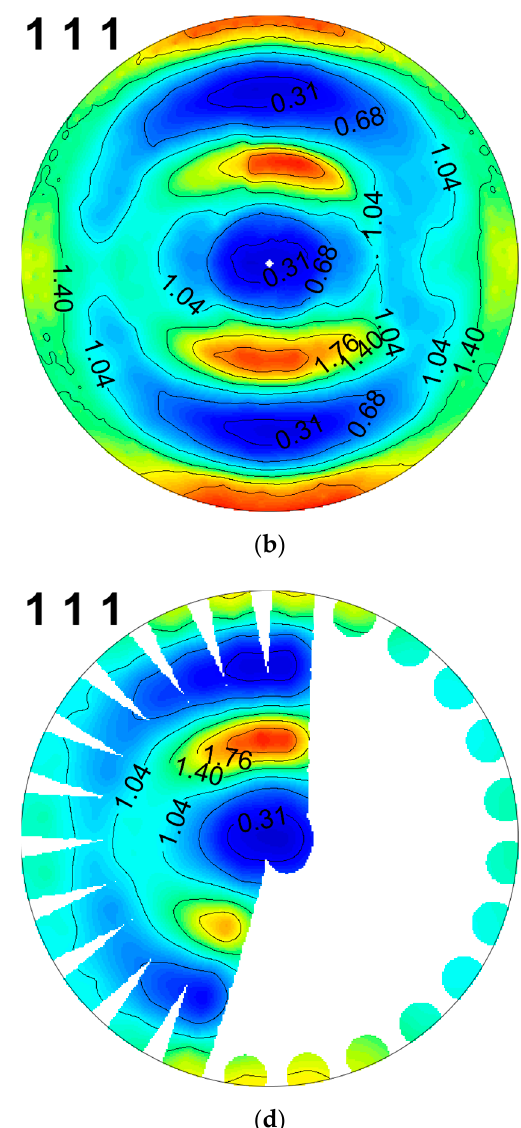
and solid • (cid:35)